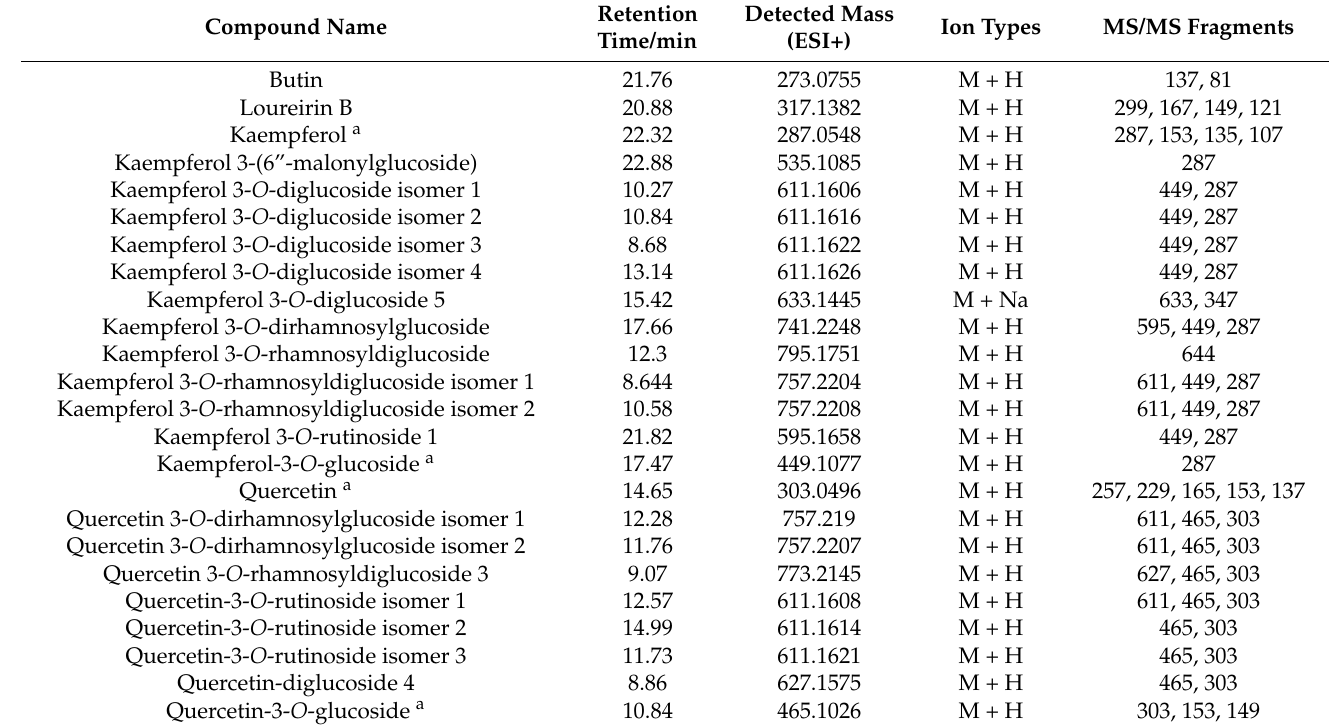
a Confirmed by the authentic standards.